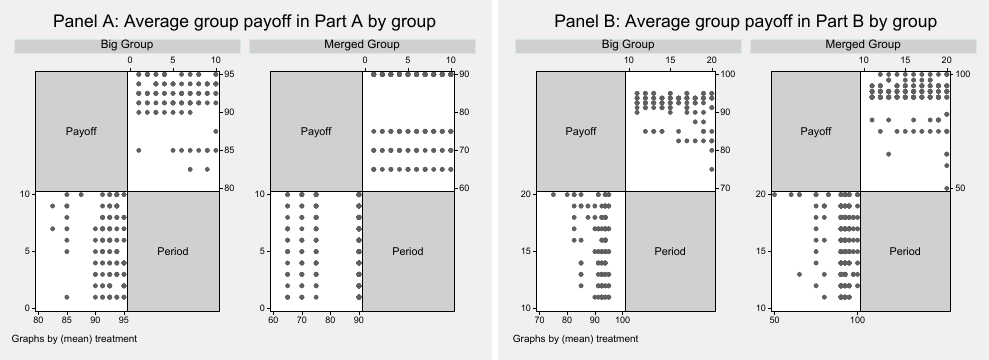
Figure A5. Average group payoff in Part A and Part